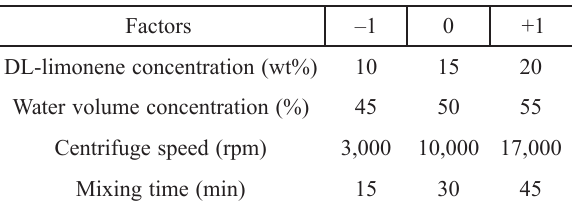
Table 4 – Formulations of DL-limonene microemulsion gen- erated by Minitab Statistical